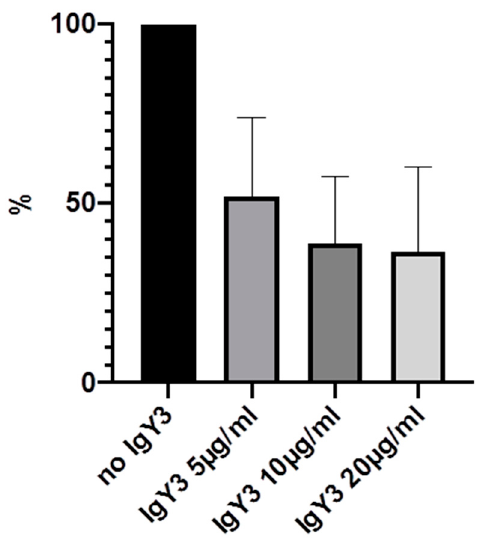
Molecules 2020 , 25 , x FOR PEER REVIEW Figure 5. Inhibition of biofilm formation in % after 24 h incubation with 5, 10 and 20 µg/mL IgY3.